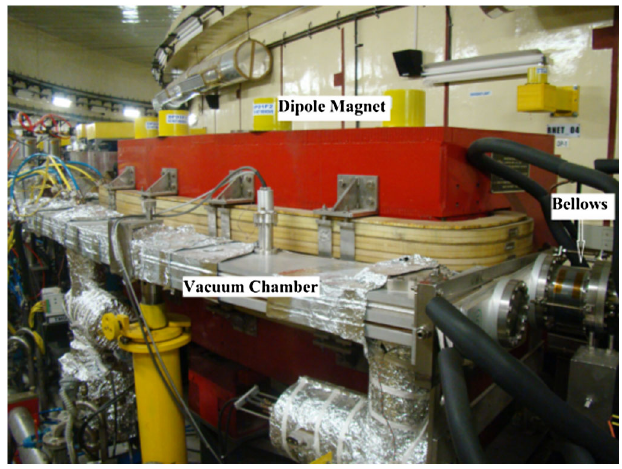
FIG. 1. The vacuum chamber made of aluminum alloy is placed inside the pole gap of a dipole magnet and approximately 60% of it is lying outside the pole gap and exposed to a nonuniform